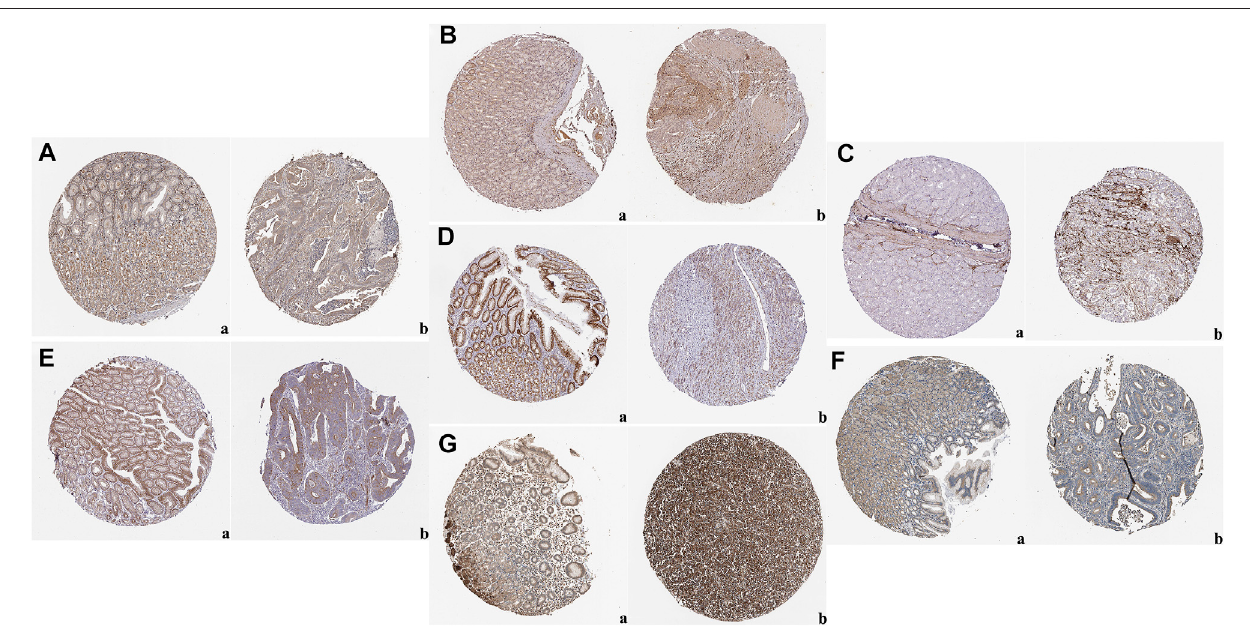
FIGURE 5 | Representative images of immunohistochemical staining of normal gastric tissue (panel a) and gastric cancer tissues (panel b) based on the Human Protein Atlas: (A) ADAM Metallopeptidase With Thrombospondin Type 1 Motif 2 (ADAMTS2); (B) Collagen Type I Alpha 2 Chain (COL1A2); (C) Collagen Type VIII Alpha 1 Chain (COL8A1); (D) CTHRC1; (E) FAP; (F) Thrombospondin 2 (THBS2); (G) WNT1-inducible-signaling pathway protein 1